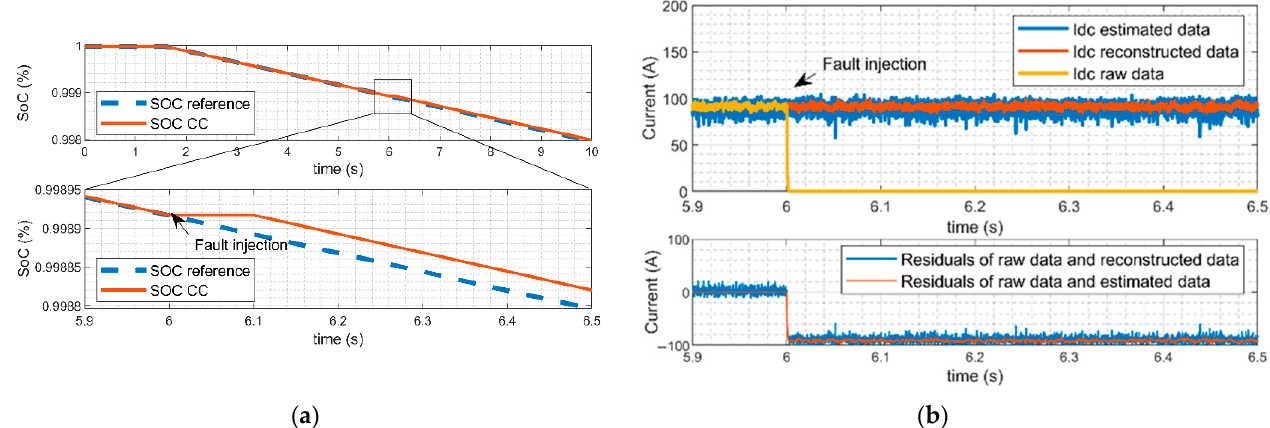
Figure 15. System response of DC bus current sensor fault. ( a ) Estimated and reference values of SoC; ( b ) DC bus current signal and its residual.